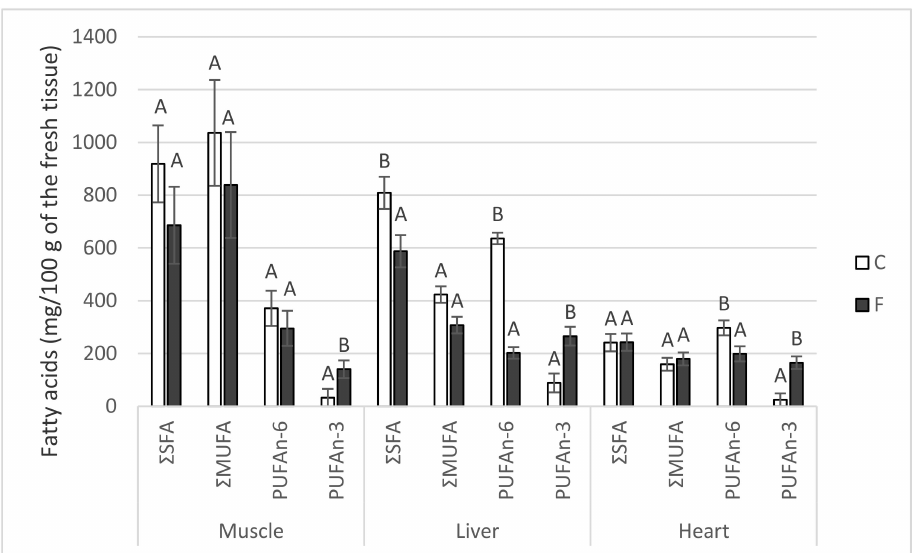
Figure 1. Deposition of fatty acids in the selected tissues of pigs fed for four weeks on either the control standard feed mixture (C) or feed mixture enriched with 8% fish oil (F); SFA—saturated fatty acids (myristic, palmitic, heptadecanoic, stearic); MUFA—monounsaturated fatty acids (palmitoleic, oleic); PUFA—polyunsaturated fatty acids (n-6: linoleic, γ -linolenic, eicosadienoic, homo- γ -linolenic, arachidonic, docosatetraenoic; n-3: α -linolenic, eicosapentaenoic, docosapentaenoic, docosahexaenoic). Means with di ff erent letters within the given parameter di ff er at p < 0.05 (independent groups t -test; n =